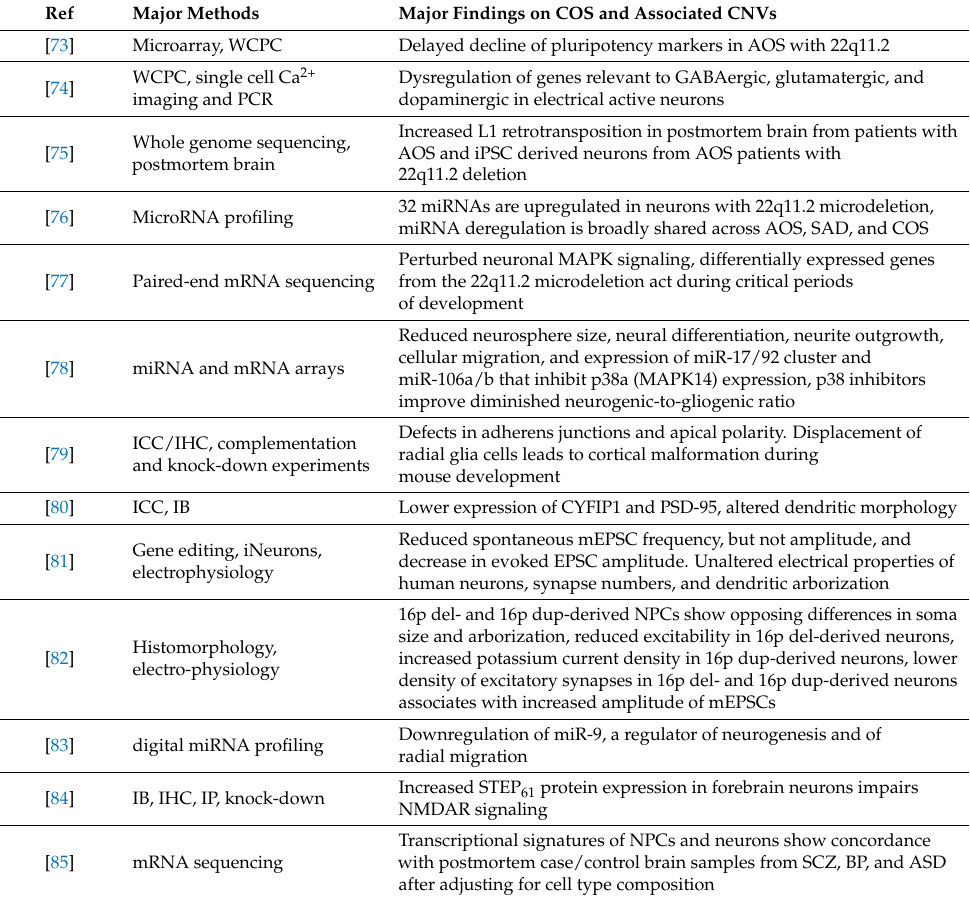
Table 5. Major methods and findings on COS associated CNVs and on